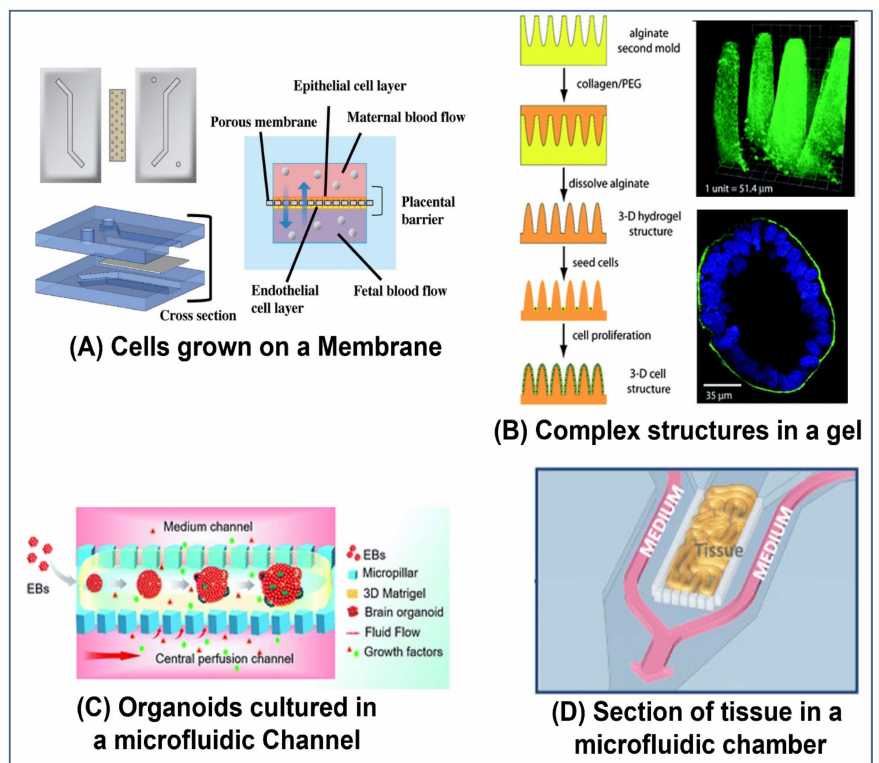
Figure 1. Types of organ-on-a-chip models: ( A ) A model that cultures cells on a porous